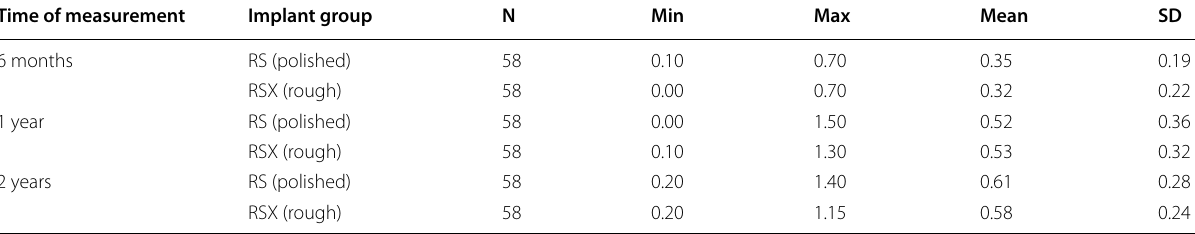
Mean marginal bone levels differ only slightly in between the two groups